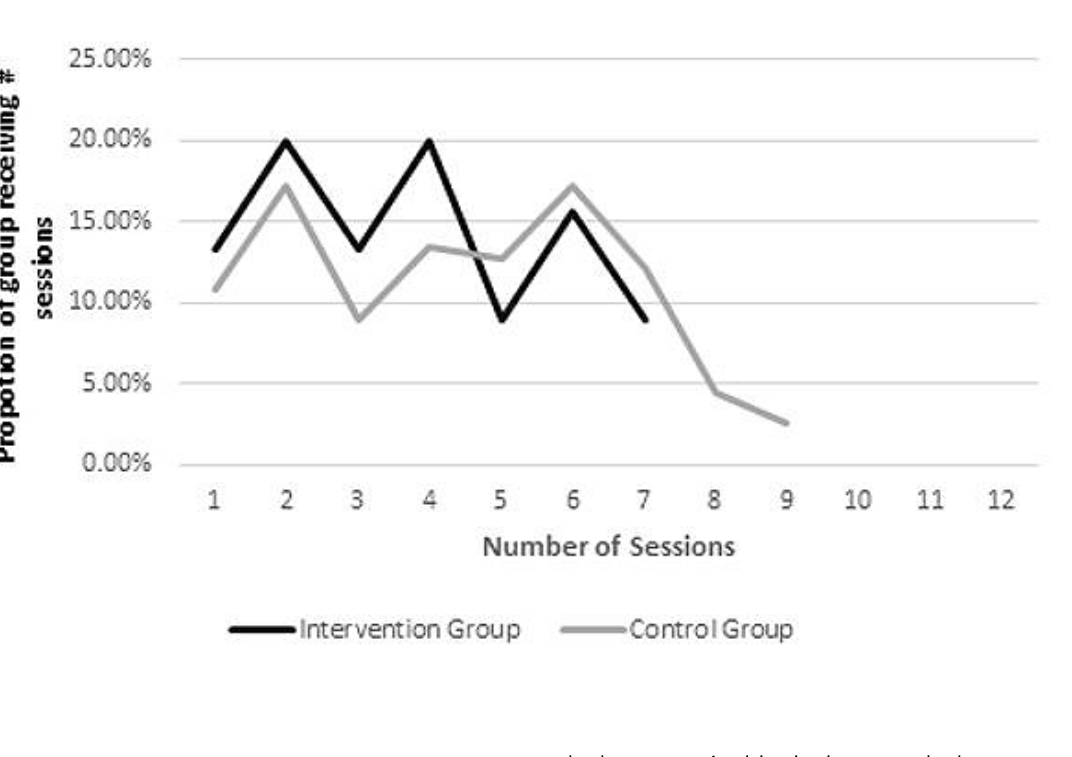
Figure 3. Proportion of intervention and control participants by number of sessions